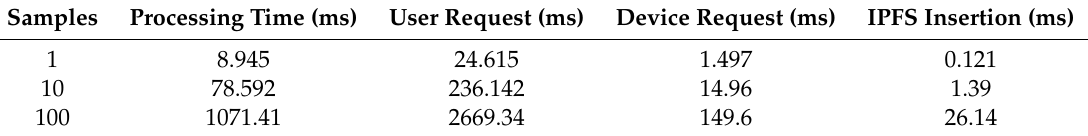
Table 6. PUT Results.